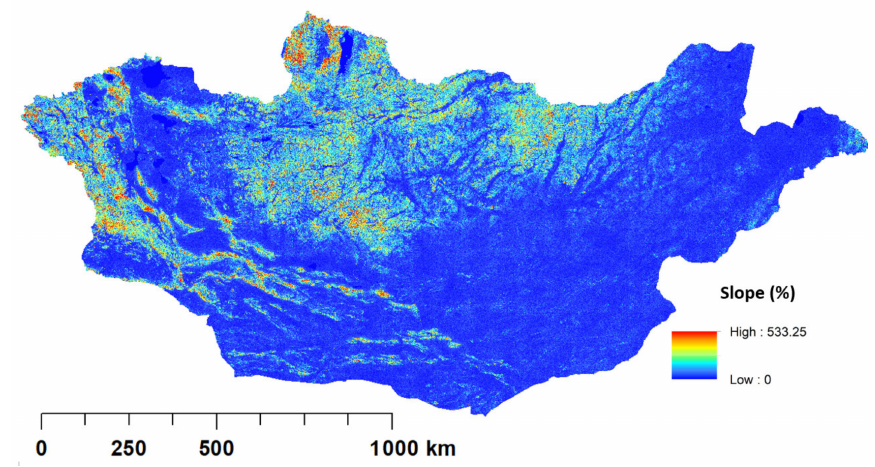
Figure 6. Slopes of Mongolia derived from a digital elevation model.